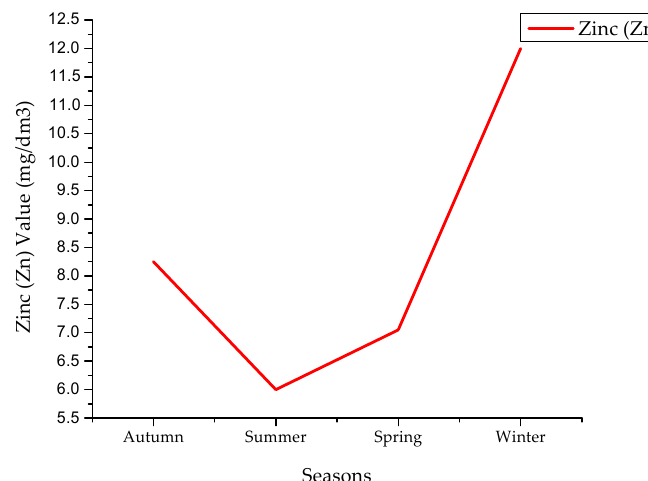
Figure 13. Concentration values for (Zn) from image during four seasons.